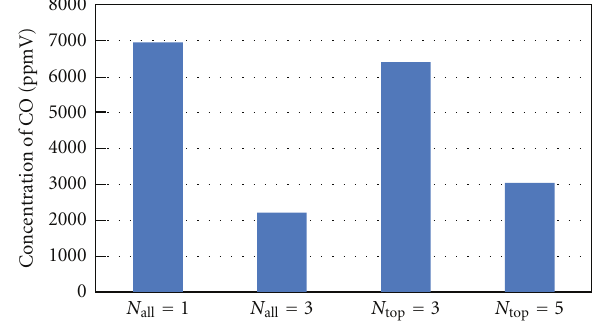
Figure 13: Comparison of product by CO 2 reforming after illumination of Xe lamp with UV light of 72 h for several Ag-doped TiO 2 film prepared under conditions of di ff erent N